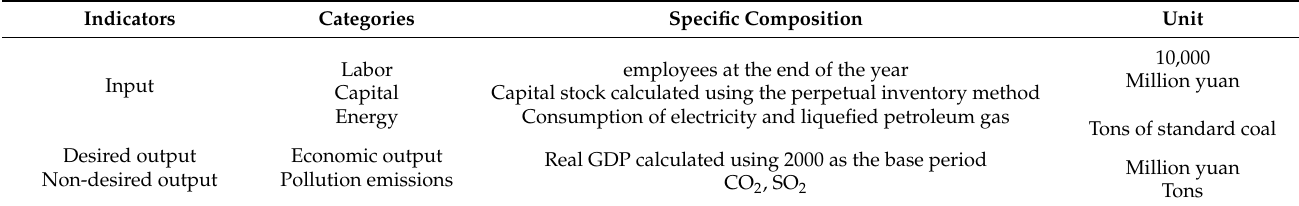
Table 1. Meaning and measurement of energy efficiency